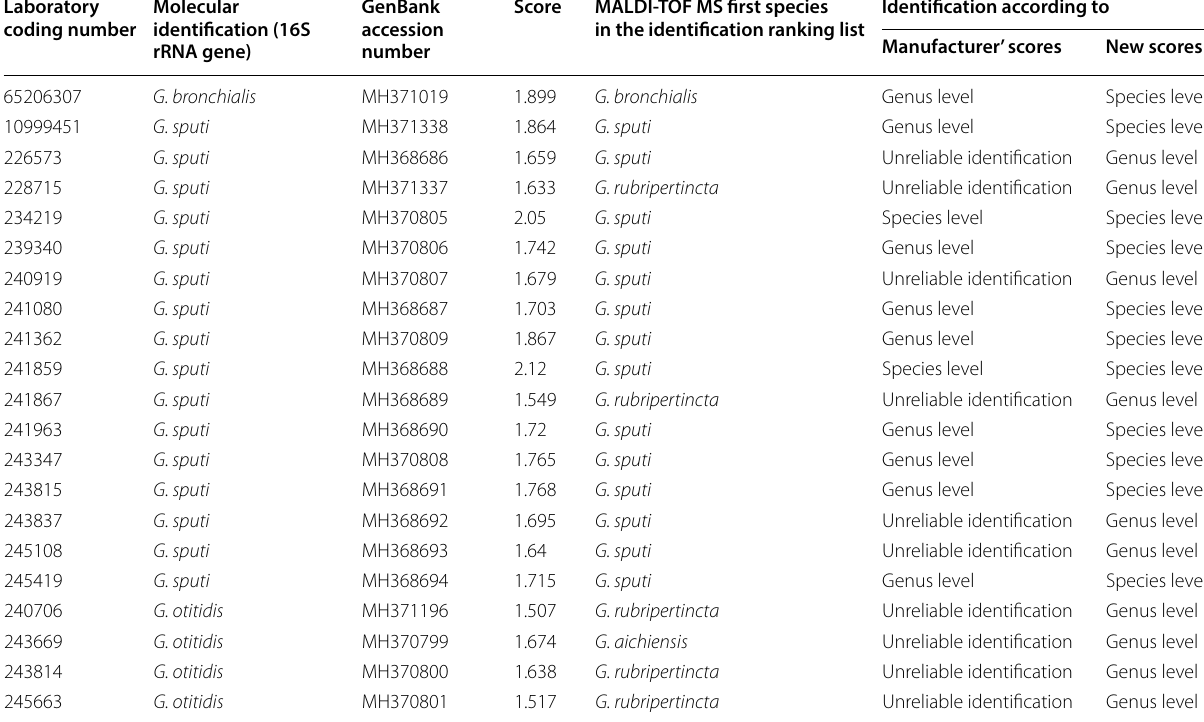
Table 1 Gordonia species identification by 16S rRNA gene sequencing and correlation with MALDI-TOF MS Laboratory Molecular coding number identification